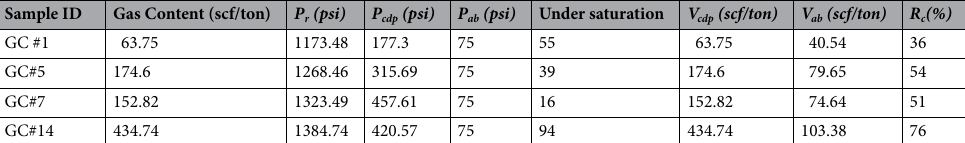
Table 6. The primary recovery factors of methane. P r Reservoir pressure , P cdp Critical desorption pressure , P ab Abandoned Pressure , V cdp Gas content at P cdp , V ab Gas content at P ab , R c Recovery factor .